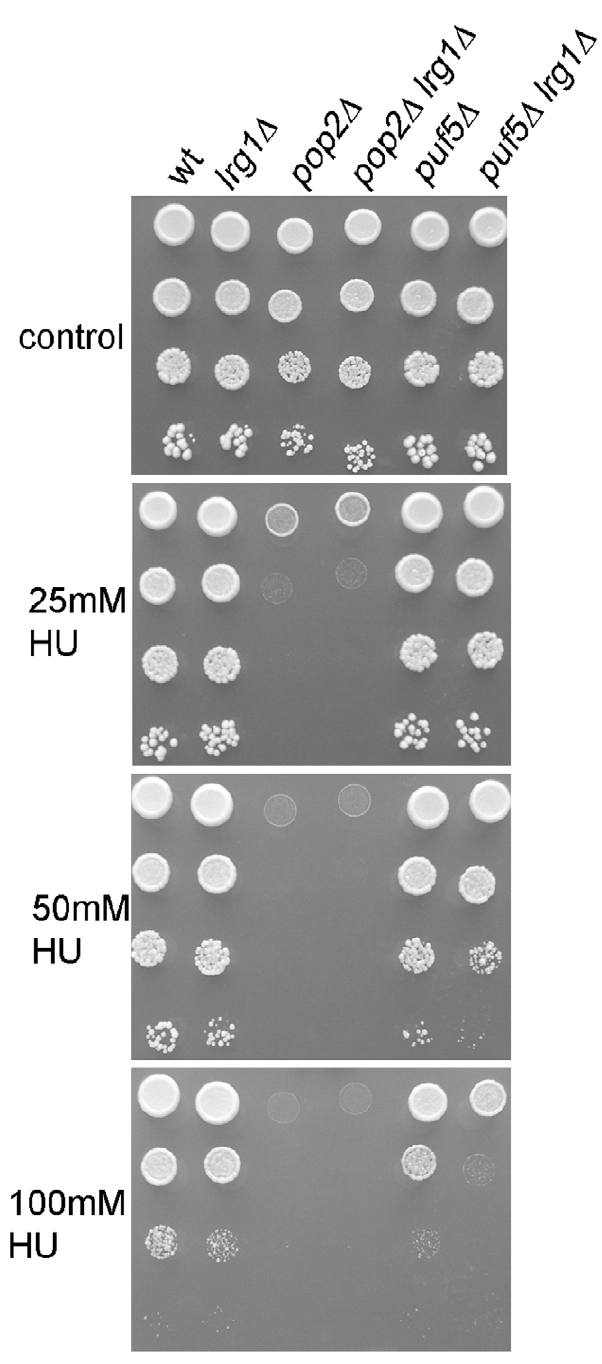
Figure 5. LRG1 is not the relevant mRNA target for the roles of Puf5 in response to HU. Cells of the indicated strains were dropped on plates with or without HU and photographed after three days of growth at 30 u